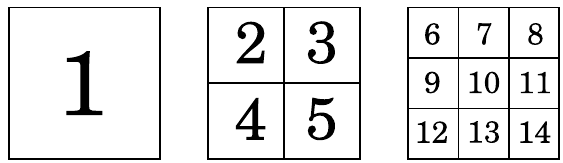
Figure 4. Pose estimators used to compute the pose-indexed feature. The pose estimators are calculated in the sliding windows r × r in different positions and